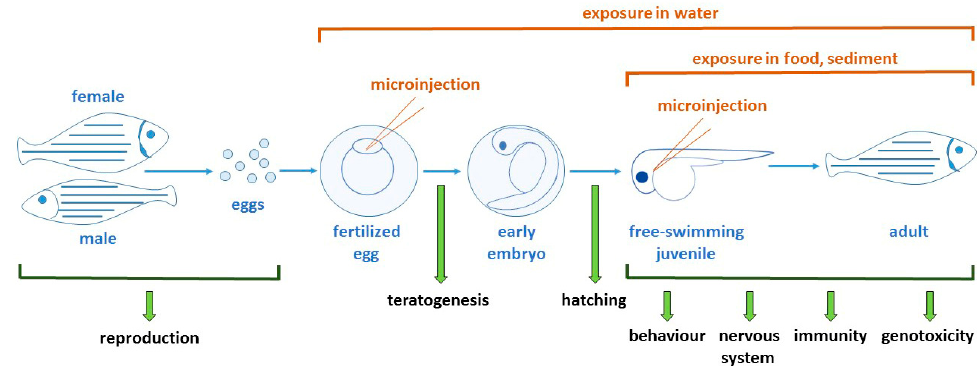
Figure 1. Toxicological studies performed in zebrafish. Schematic representation of zebrafish development, from spawning of embryos through their rapid development and hatching into free-swimming larvae and further growth and development into adults. Nanoparticles (NPs) can be administered via a variety of routes, including injection into eggs or specific sites on juveniles and adults, or alternatively administered in the water, sediment or food. The key assays used to examine toxicity in this model are indicated.